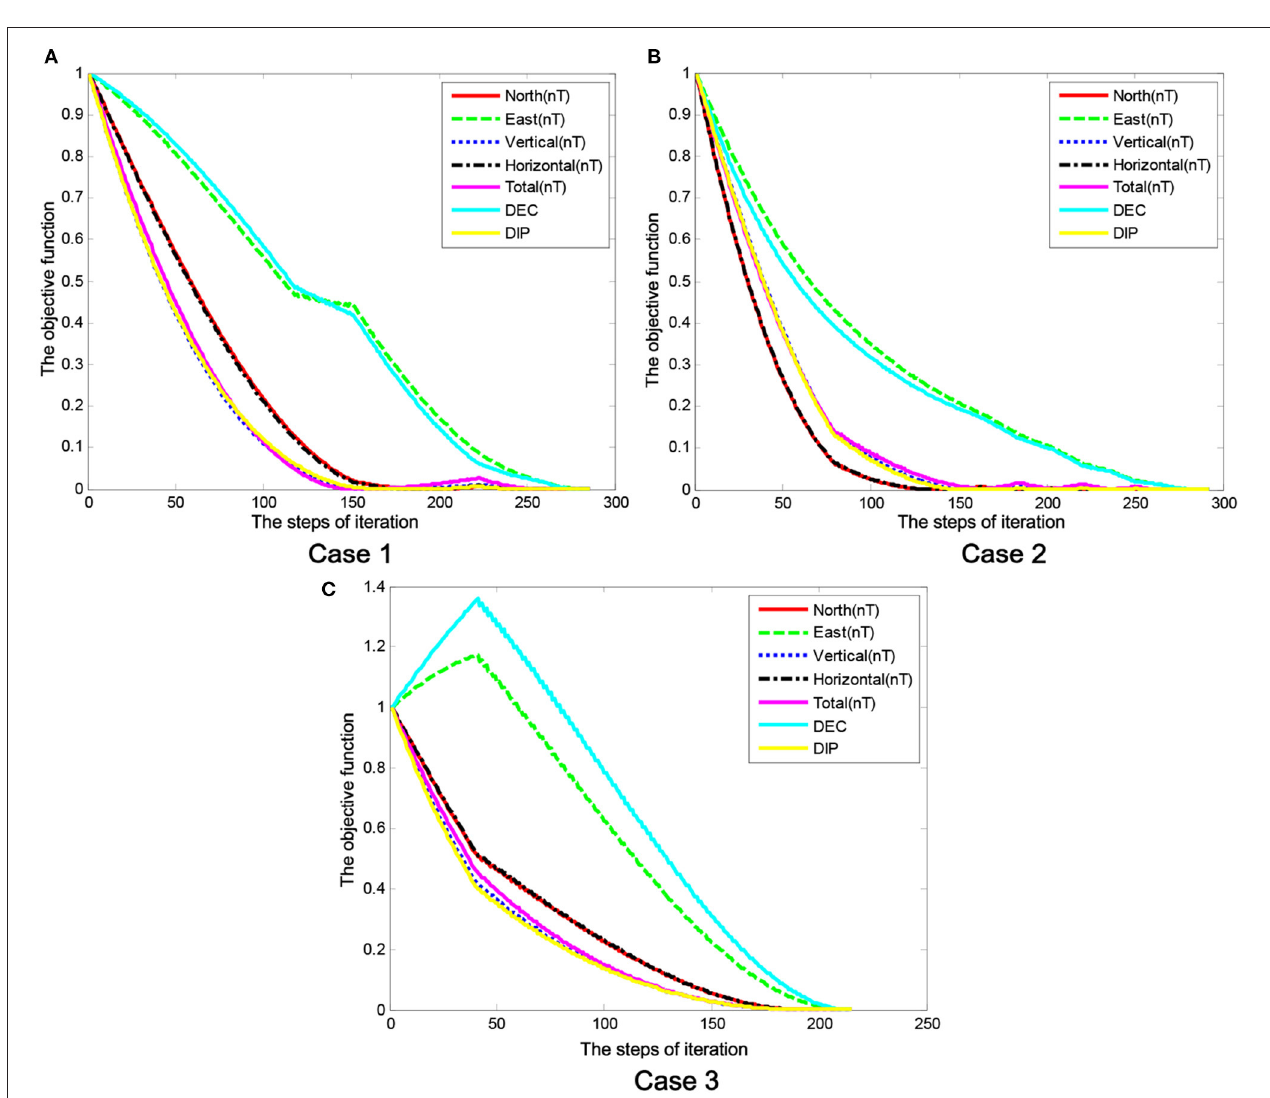
FIGURE 7 | The geomagnetic multi-parameter convergence curves. (A) Case 1, (B) Case 2, and (C) Case 3.